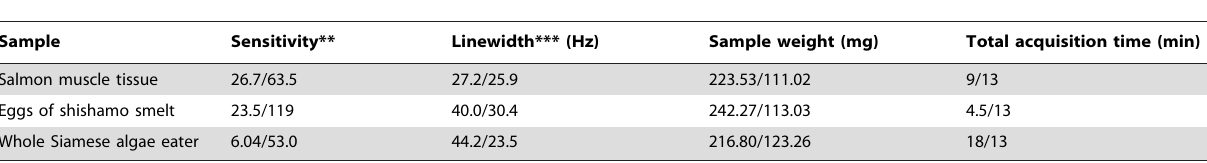
Table 4. Comparison of spectra-related information from the iMQC and MAS